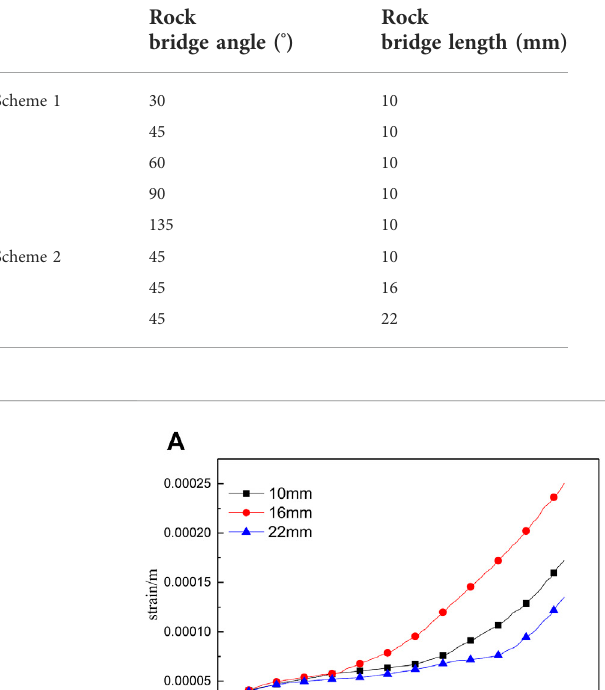
TABLE 4 Calculation scheme: dual parallel fractures.